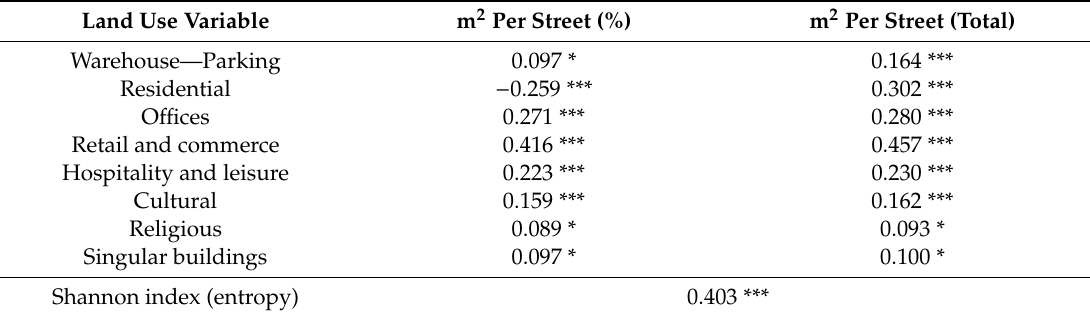
Table 6. Spearman correlation test (Rho) between the number of visitor’ STTs and land uses per street